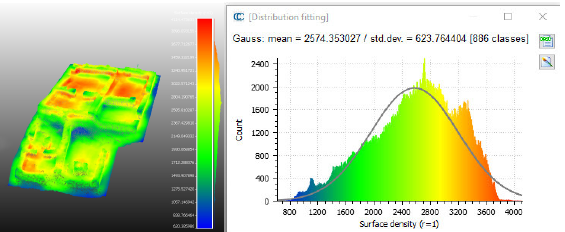
Figure 10a. Density analysis of the project 7 (all the five acquisitions) – Sample A